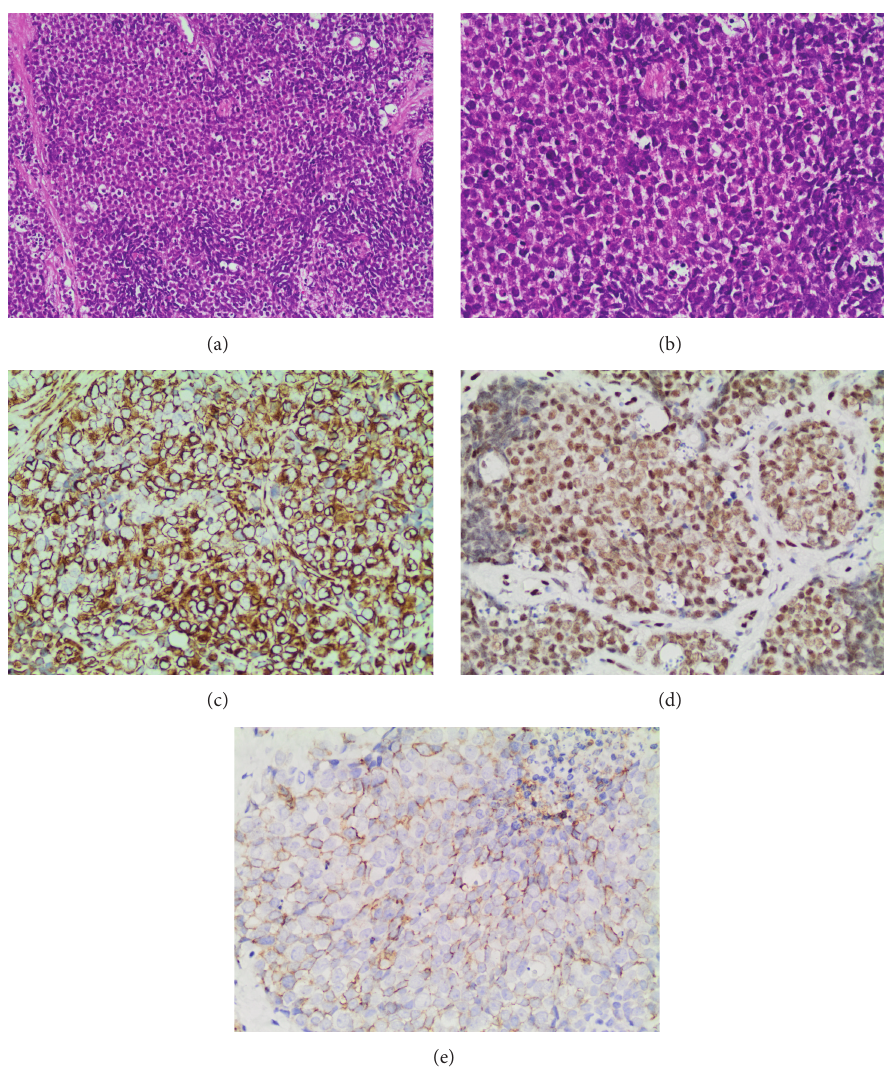
Figure 2: (a) Tumor cells are uniform small round cells with round nuclei containing fine chromatin, high nuclear to cytoplasmic ratio, and indistinct cytoplasmic membrane (H&E; 20x). (b) Tumor cells are uniform small round cells with round nuclei containing fine chromatin, high nuclear to cytoplasmic ratio, and indistinct cytoplasmic membrane (H&E; 40x). (c) Immunohistochemical staining for vimentin (40x). (d) Immunohistochemical staining for FLI1 (40x). (e) Immunohistochemical staining for CD99